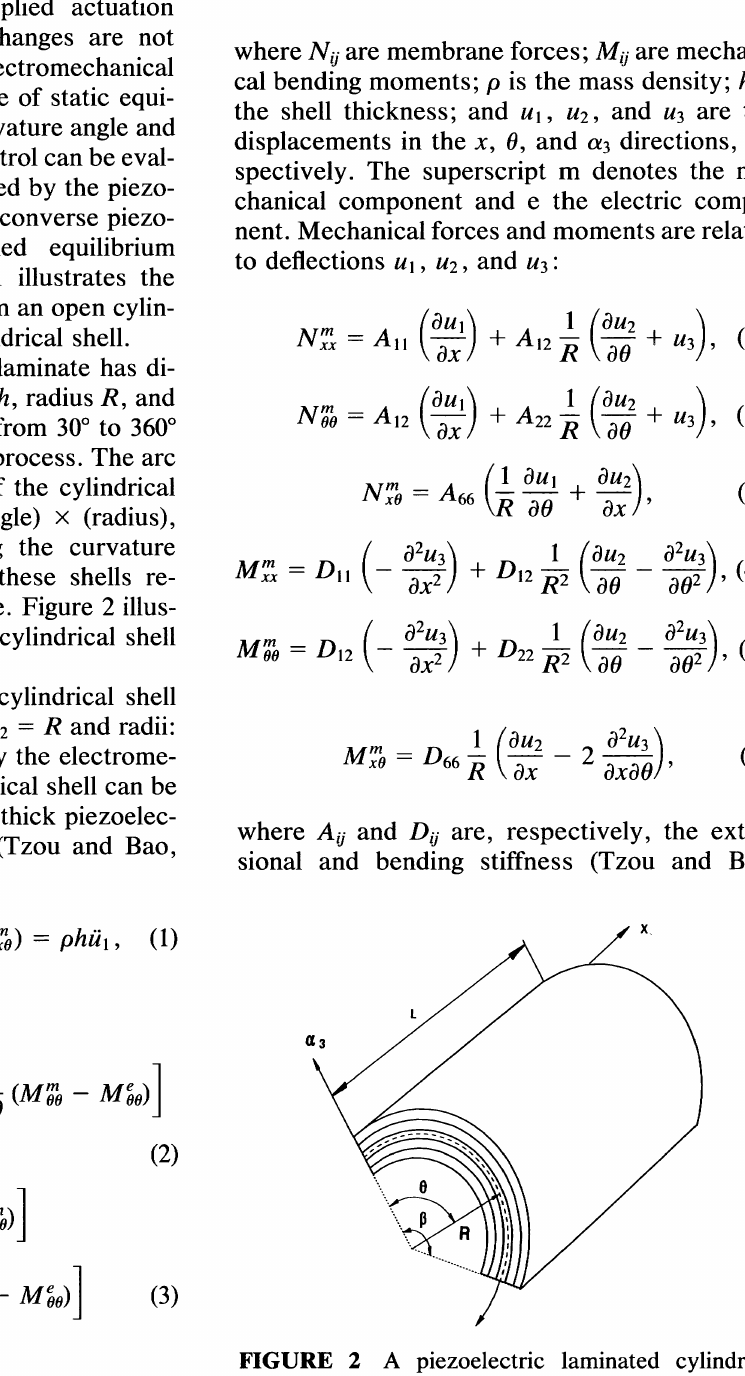
OQIJ· .. FIGURE 1 Shell transformations,